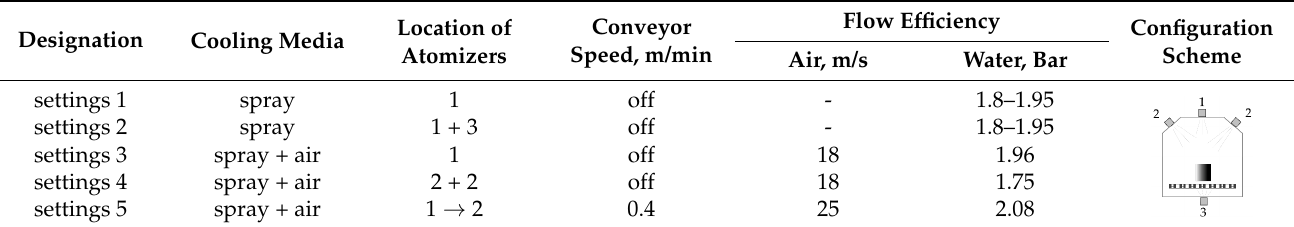
Figure 1. Geometry of samples used in the study: ( a , b ) samples used for validation of the estimated heat transfer coefficient, where T1÷T4 are designations of thermocouples Determination of heat transfer coefficient functions involved settings (air/water pres- sure, velocity, configuration, etc.) reasonable from the standpoint of their utilization in cooling cycles designed for forged cardan in the continuous cooling line. Thus, a series of combinations of spray inlet(s) with or without action of accelerated air was selected, that is: upper central spray only, upper central spray plus accelerated air, upper central plus bottom central, upper slant, two sided symmetrical spray inlets and, in addition to this, spray plus air at conveyor movement. Table 1. The cooling conditions selected for measurement of the heat transfer coefficient. The cooling conditions occurring in the cooling zone, correspondingly to conditions expected during cooling tests, are given in Table 1.